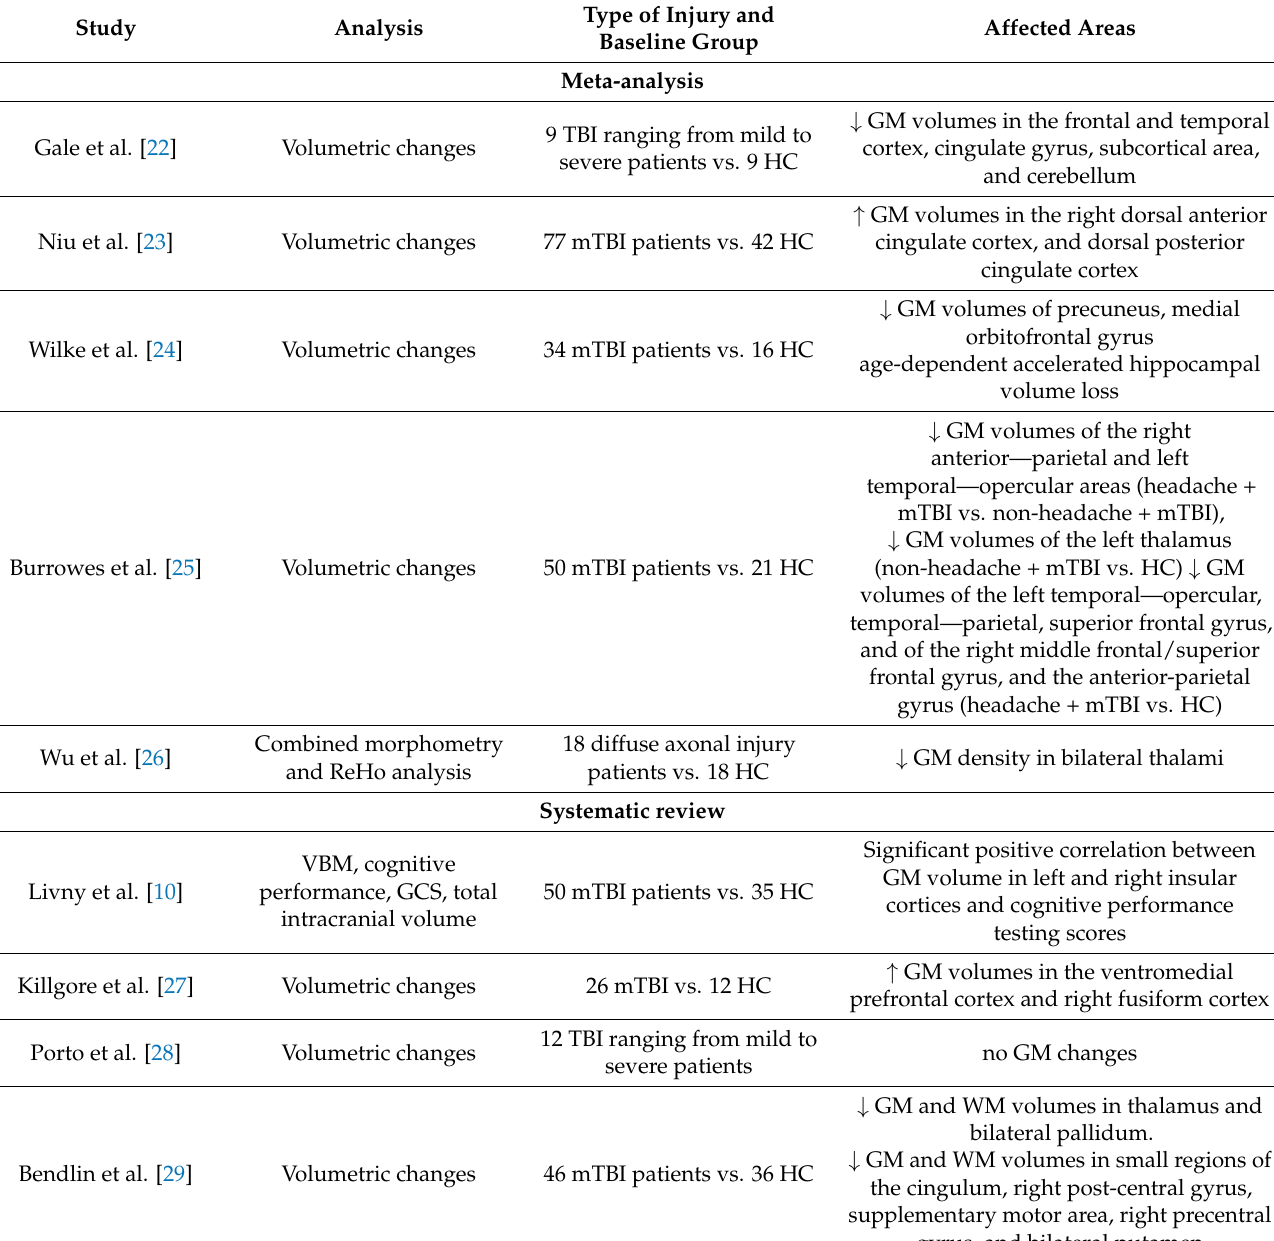
Table 1. Summary of the main findings and characteristics of the studies included in the present review and